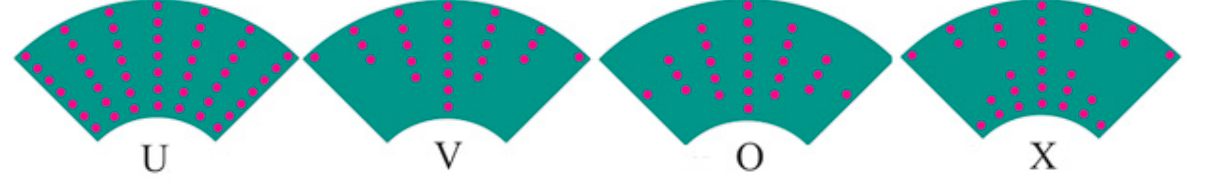
Figure 2. CNT distribution throughout the thickness of the polymer cylindrical shell.